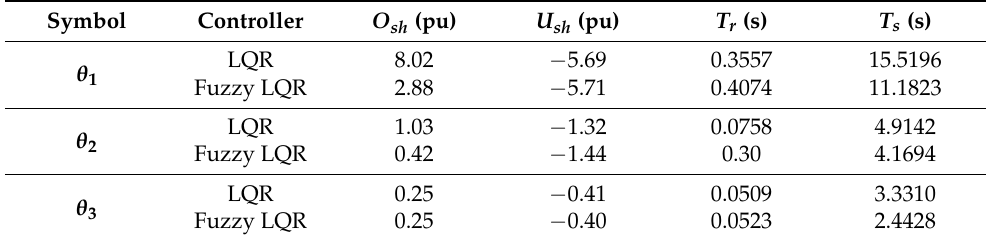
Figure 7. ( a ) The system response for the upper link of Robogymnast in Case 1 (T1); ( b ) The system response for the middle link of Robogymnast in Case 1 (T2); ( c ) The system response for lower link of Robogymnast in Case 1 (T3). Table 4. LQR vs. FLQR performance